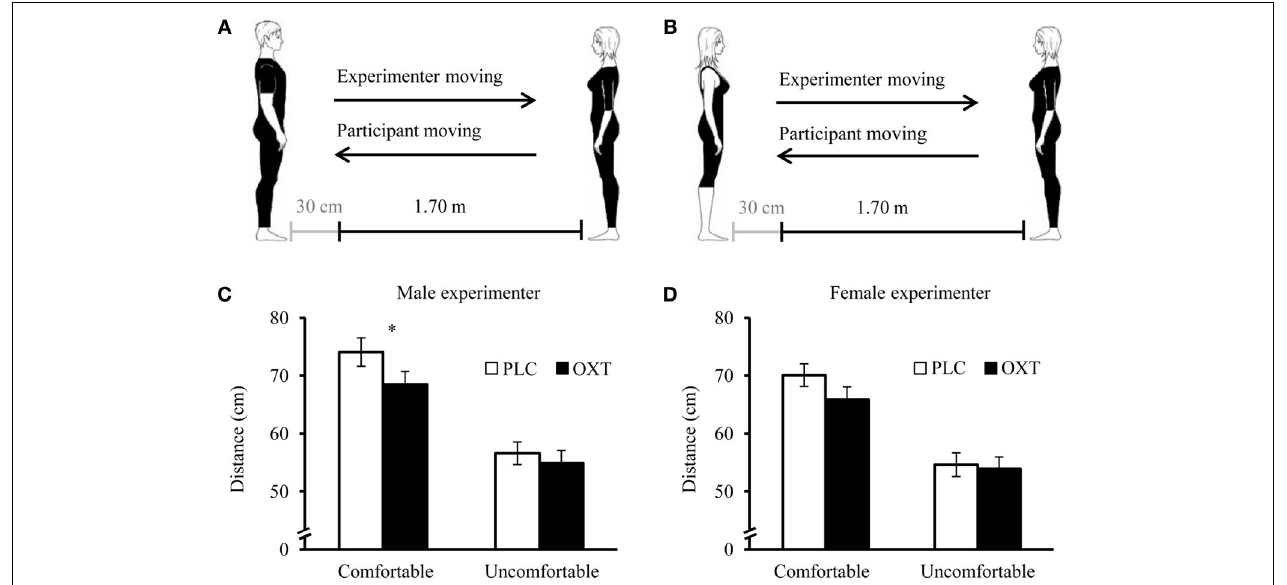
FIGURE 1 | Effects of OXT in the stop-distance-paradigm. Experimental setup for the male (A) and female experimenter (B). In the first half of the trials the experimenter was the one moving either toward (“far,” i.e., start distance of 2m) or away from the subject (“close,” i.e., start distance of 30cm), whereas in the second half the female volunteer was the one approaching or withdrawing. An additional condition was gaze direction, with